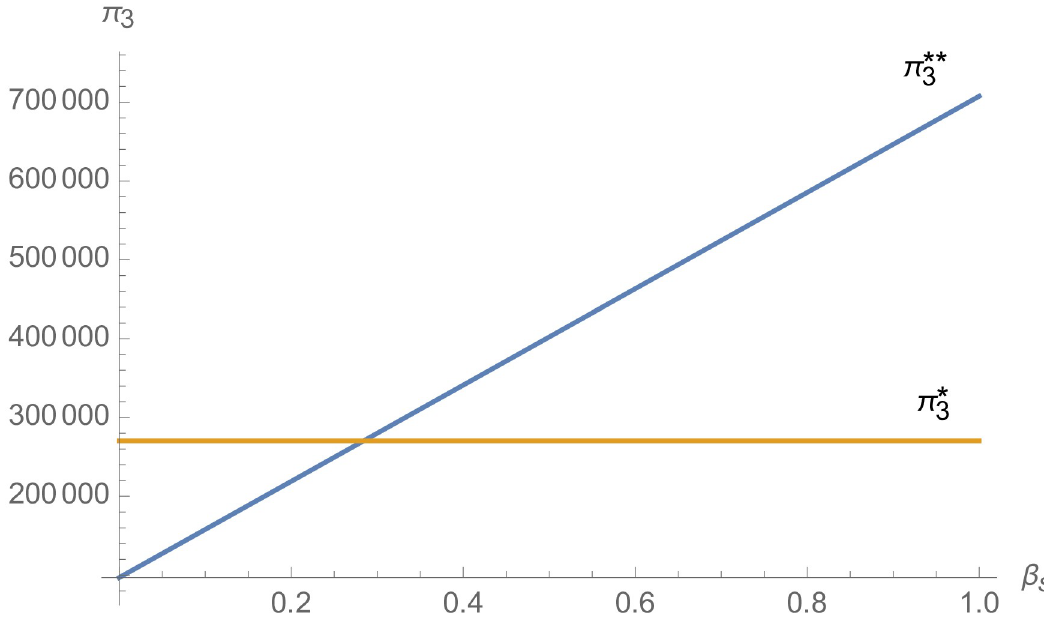
Fig 29. The impact of β